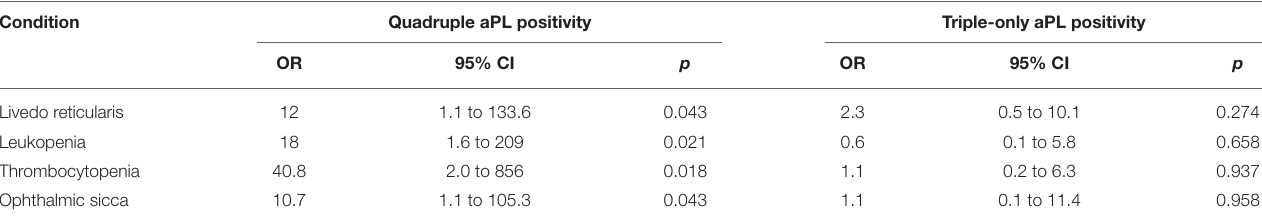
TABLE 4 | Clinical characteristics of APS patients with quadruple (left) and triple-only (right) aPL positivity vs. patients with single or double positivity. Condition Quadruple aPL positivity Triple-only aPL positivity OR 95% CI p OR 95% CI p Livedo